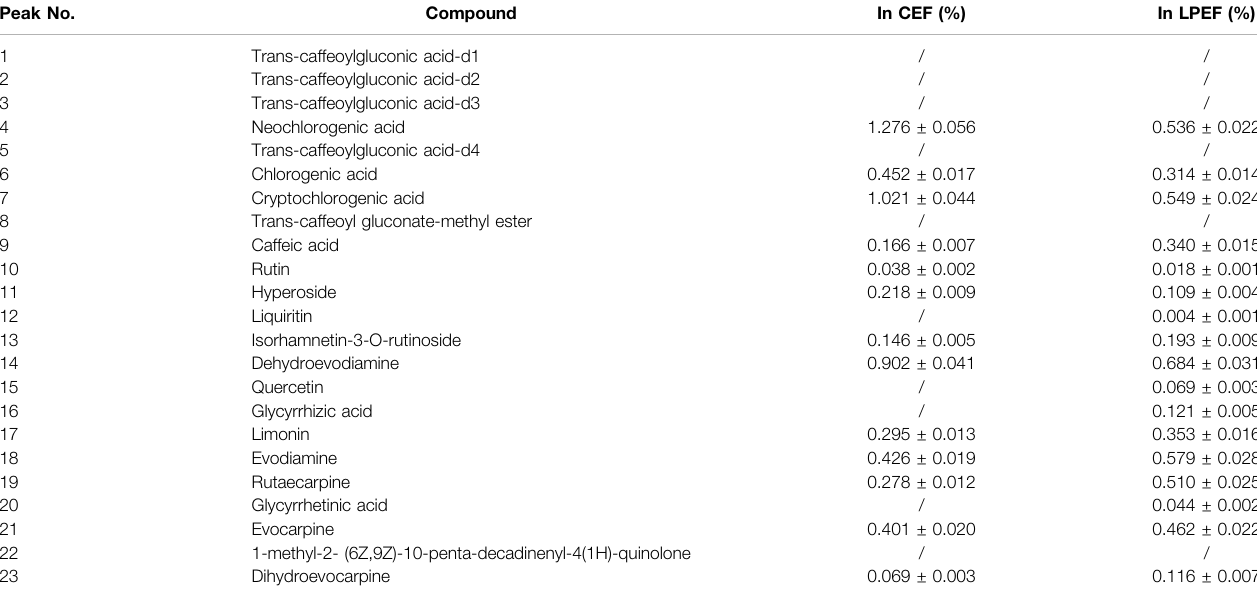
TABLE 3 | Common peaks and their contents in LPEF and CEF (mean ± SD, n (cid:2) 6). Peak